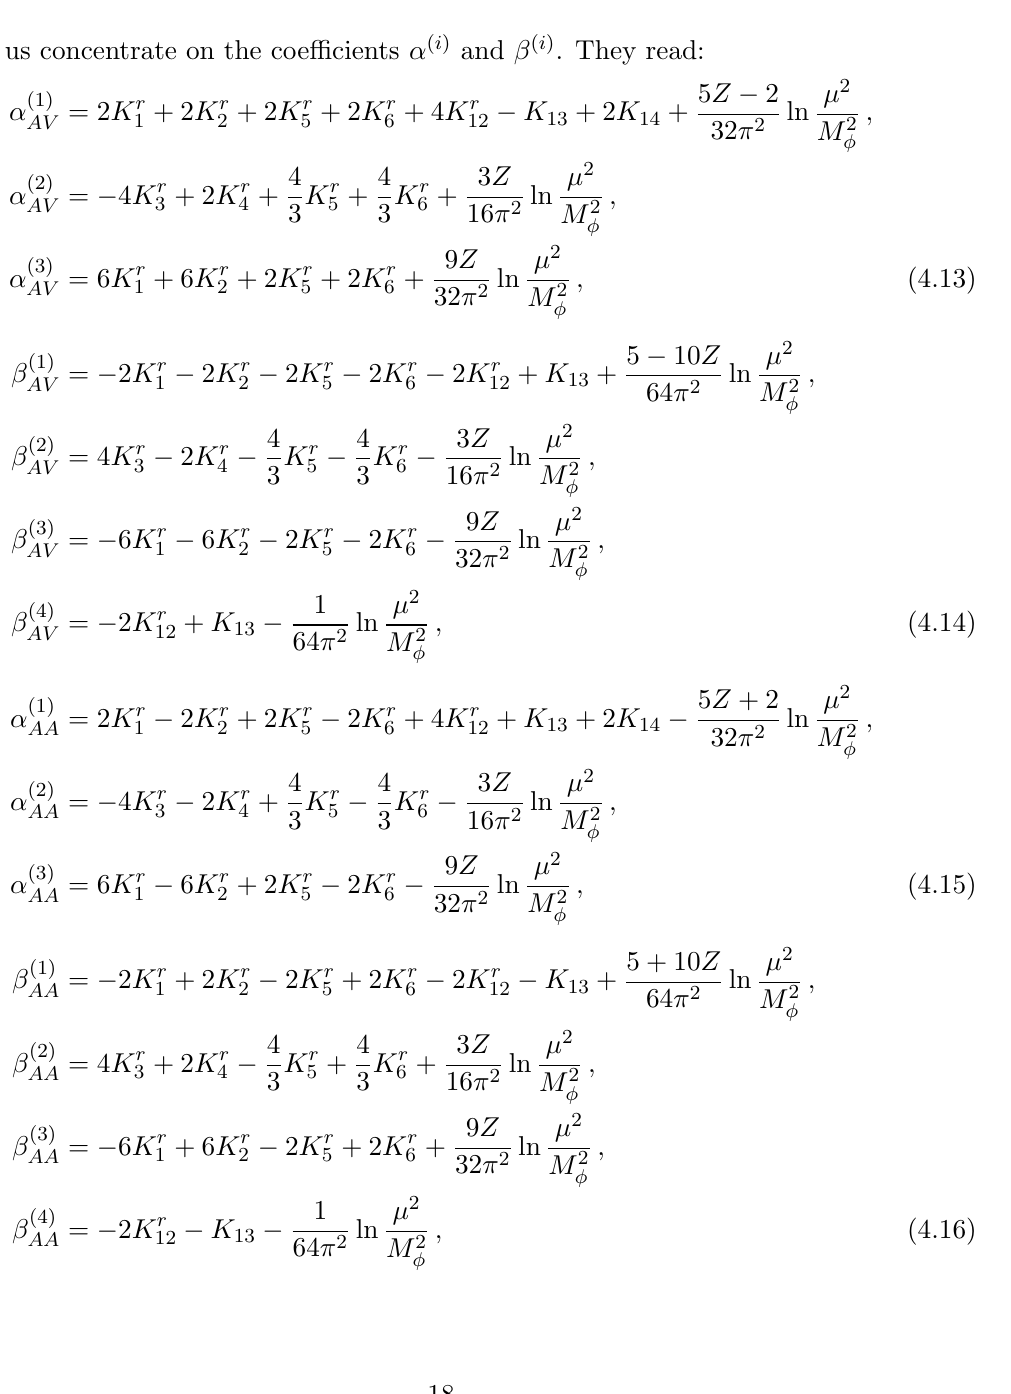
Figure 3 . LEC contributions to the correlation functions. The gray dot represents the counterterm